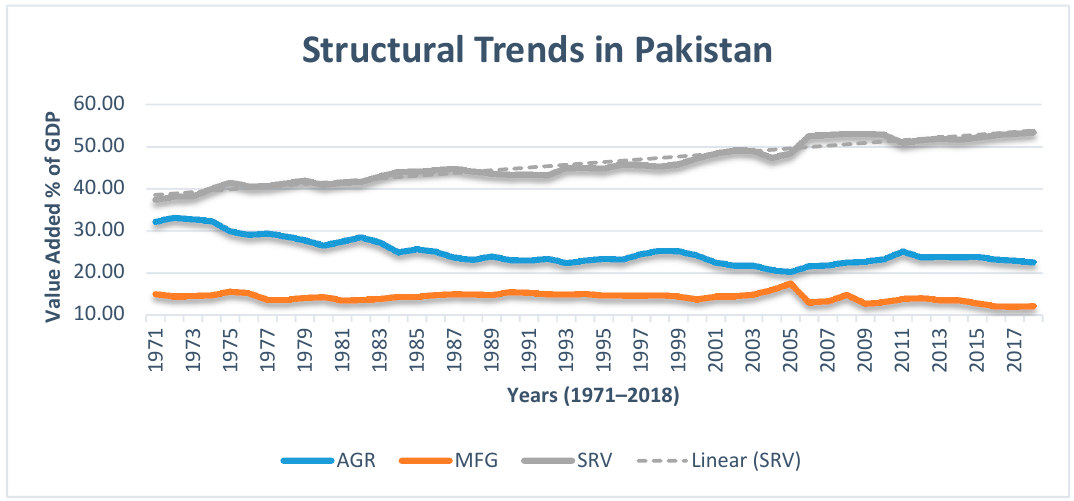
Figure 1. Sector-wise trends over the 1971–2014 period in Pakistan. Source: authors’ interpretation based on World Development Indicators (WDIs) .